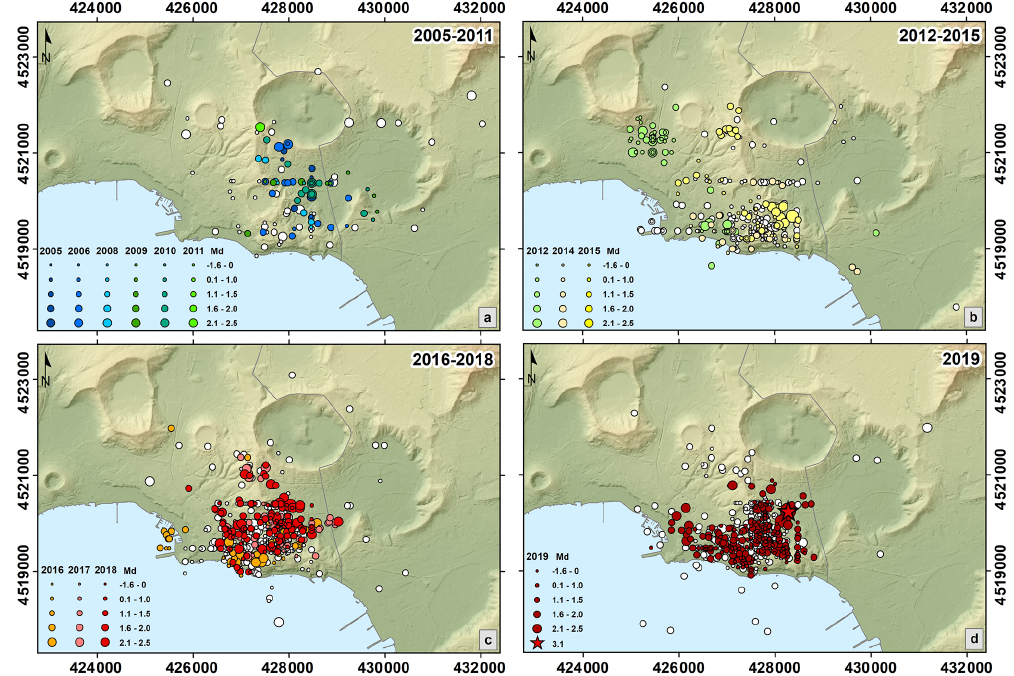
Figure 6. CF-swarms from 2005 to 2019: (a) from 2005 to 2011, (b) 2012–2015, (c) 2016–2018, and (d) 2019. The different symbols and sizes are used to indicate the year of occurrence and the magnitude value interval. The background seismicity of the related years is represented in white. DTM of Campi Flegrei (Vilardo et al., 2013). Reference system UTM WGS84.